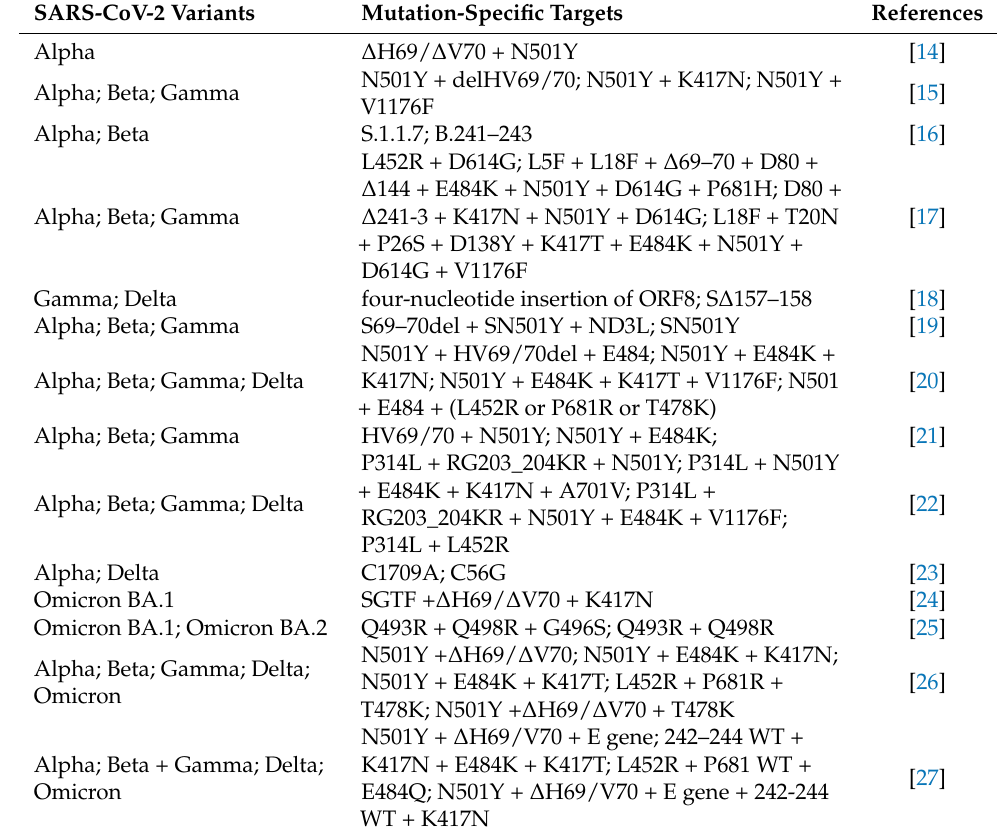
Table 1. Summary of Mutation-specific PCR Methods for Detecting SARS-CoV-2